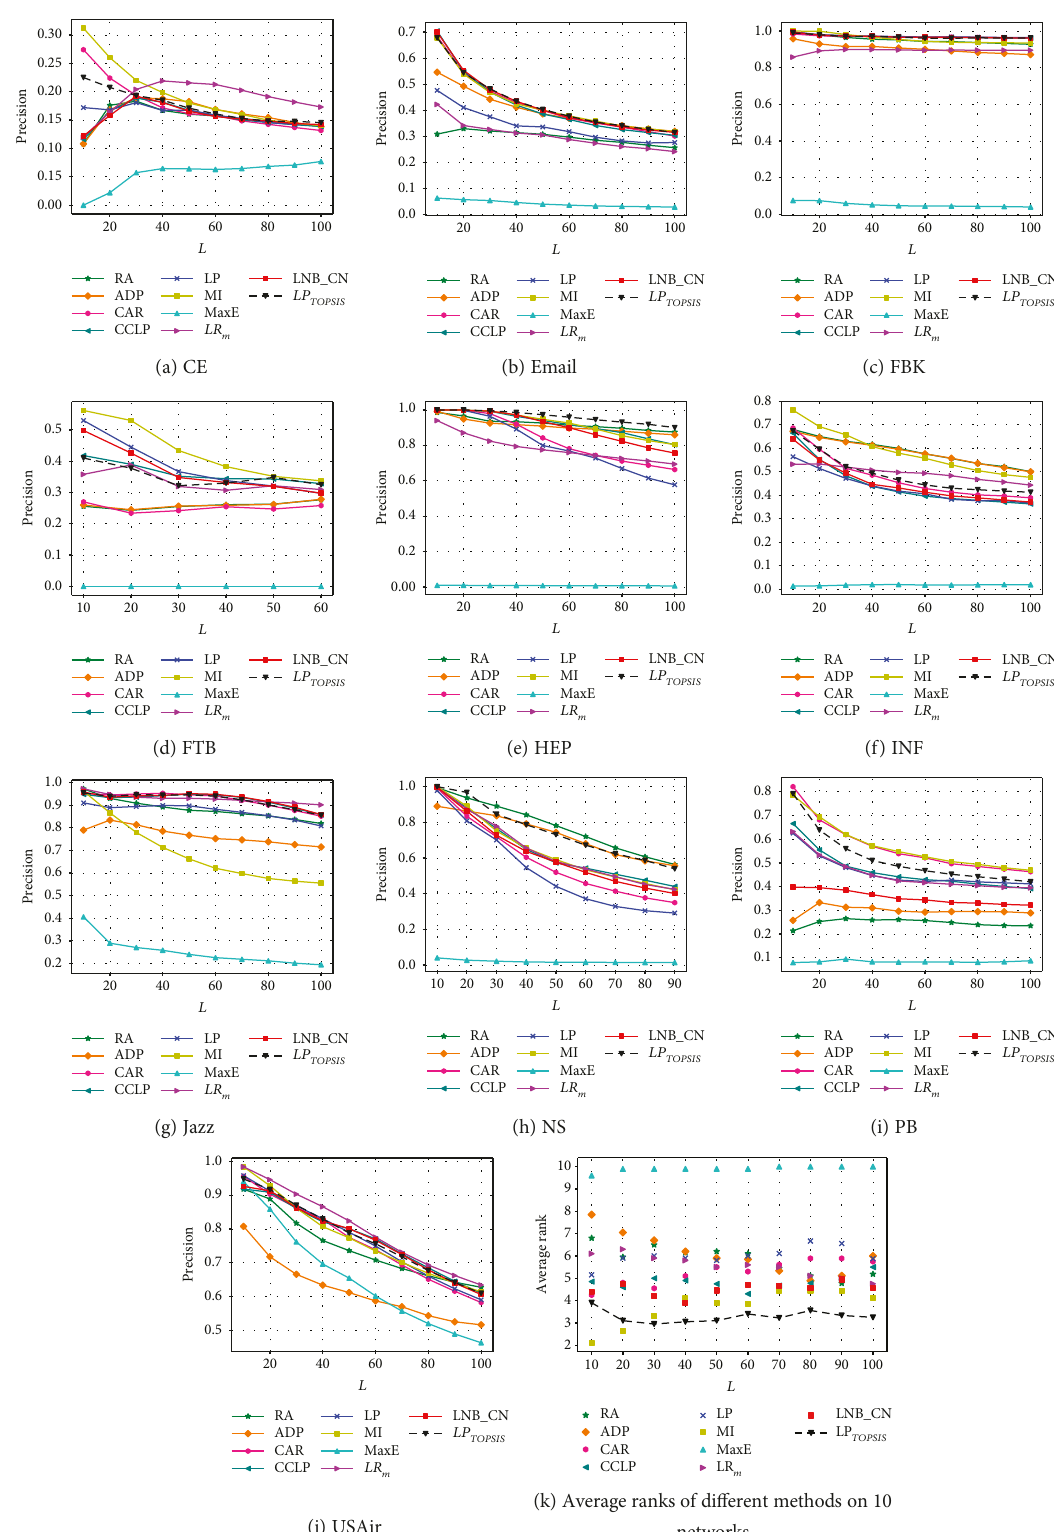
Figure 7: Precision results on 10 networks with di ff erent values of L . The results are the average of 50 independent implementations with E / E = 0 1 . The size of E for FTB is 61, so the max L selected is 60. Similarly, the max L selected for NS is ts ts